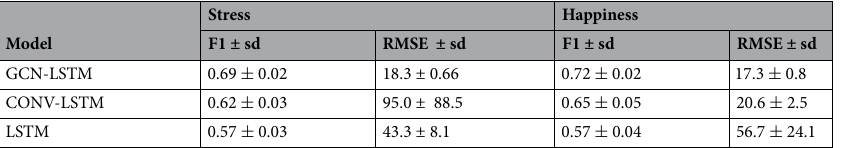
− 8 − 2 , RMSE p-value = 2.0 × 10 ) and happiness (F1